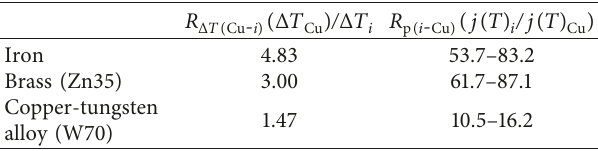
Table 4: Calculation results of R materials.